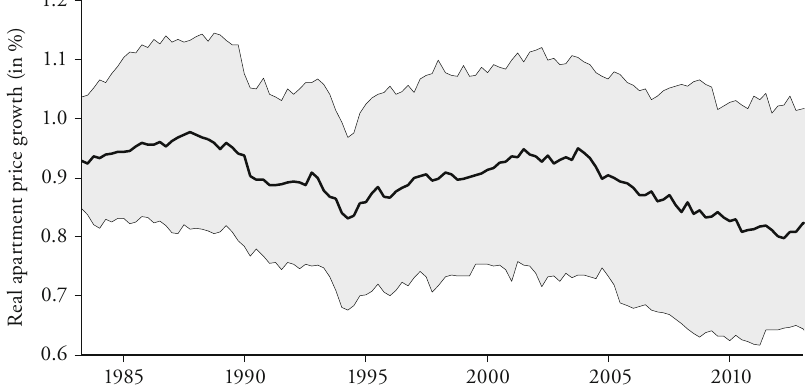
Figure 16: Peak Effect (after 5 Quarters) of Apartment Price Responses to a Shock of Mortgage Rate Level